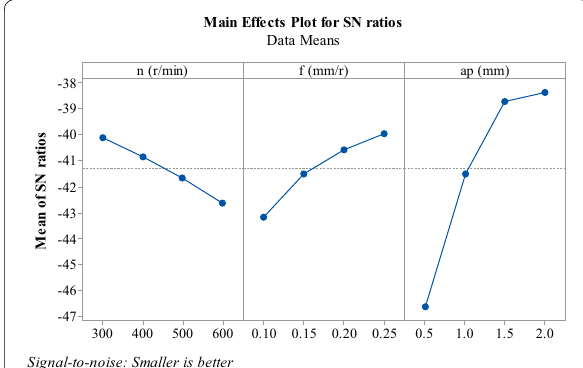
Figure 7 Main effects plot for carbon